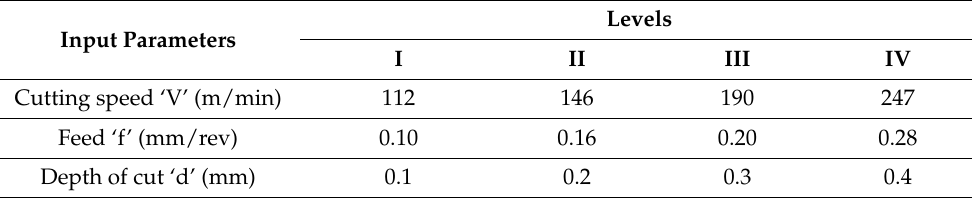
Figure 2. Cross-section morphology of coated cemented carbide tool. Table 1. Cutting variables and levels.